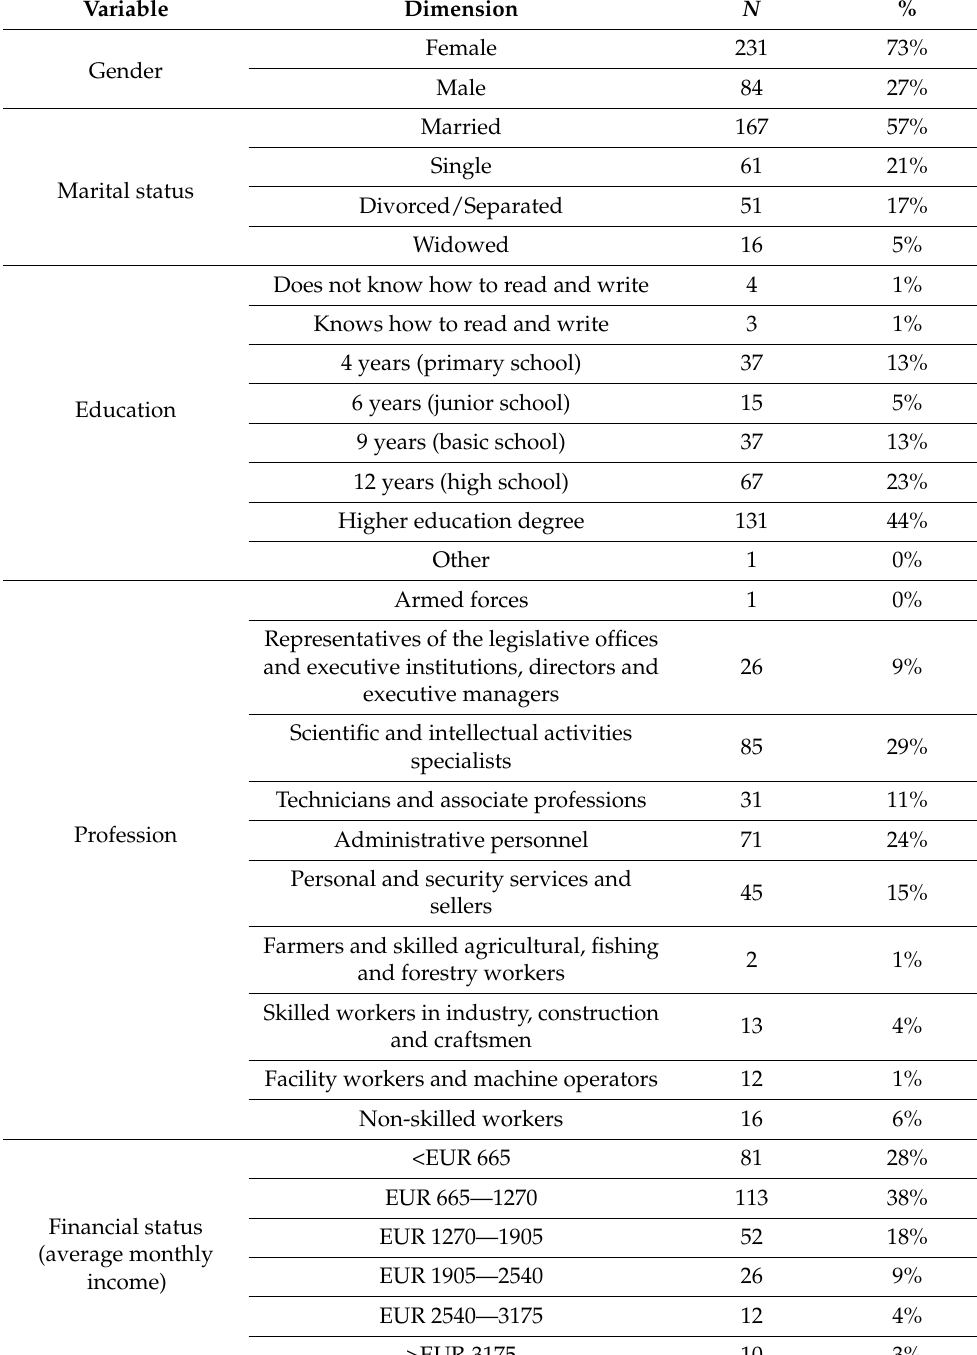
Table A1. Sociodemographic data of the informal caregiver—extended